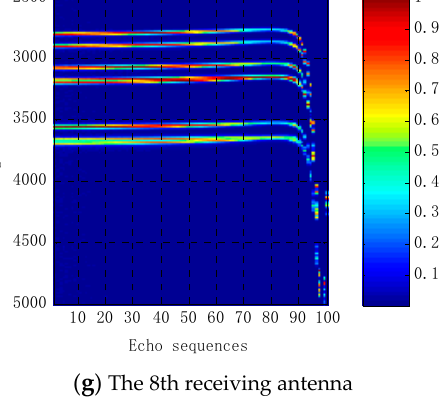
Figure 9. Results of echo sequences received by the 2nd–8th receiving antennas after Figure 9 . Results of echo sequences received by the 2nd–8th receiving antennas after translational translational compensation. 5.3. Imaging Results According to the proposed three-dimensional ISAR imaging method, the missile three- dimensional ISAR image is reconstructed using the proposed three-dimensional ISAR imaging method in this paper in a noiseless environment. As shown in Figure 10, the diamonds represent the actual position of scattering centers whose coordinates are in Table 2. Warhead scattering center and the second scattering center are reconstructed at the actual position. Scattering centers located in the junction between the rudder leading edge and cylinder are indistinguishable from the reconstructed images, because its imaging area covers all junctions. Similarly, scattering centers at the junction